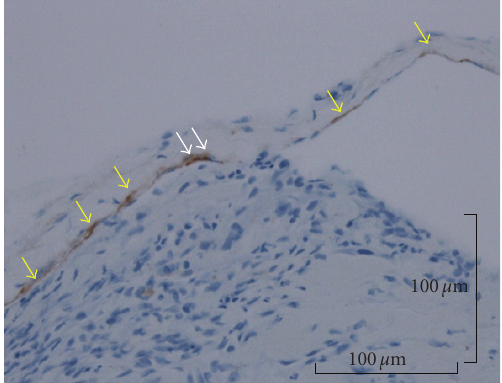
Figure 4: The endothelial cells of this lesion were reactive on immunohistochemical staining for CD31, and CD31 was posi- tive in the endothelial cells (Original magnification, × 16; Bar, 100micrometer).